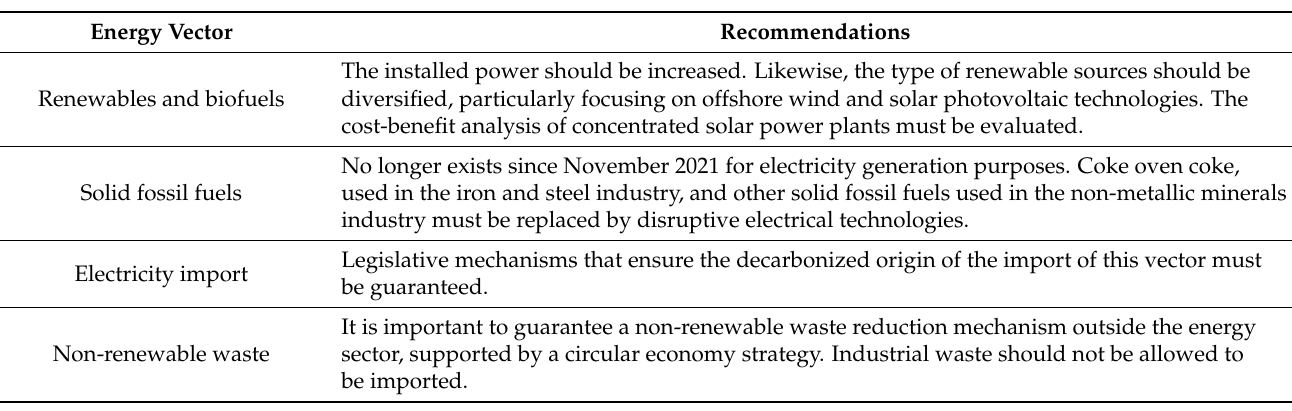
Table 2. Status of the energy vectors available from all sources.